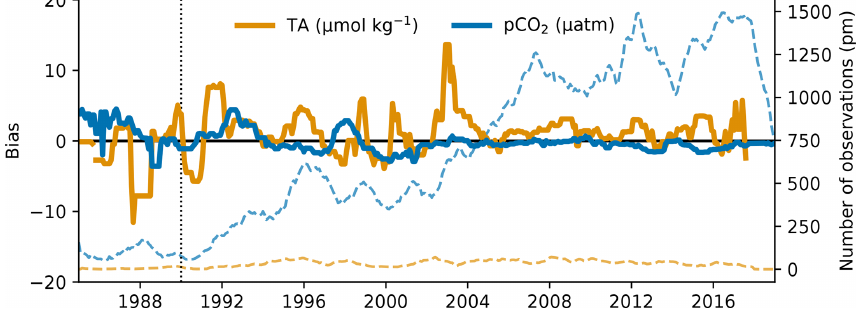
Figure A1. Time series of TA (orange) and p CO 2 (blue) estimates, with the respective training data sets (GLODAPv2 and SOCAT). The dashed lines show the number of training data (right axis). The vertical line shows the year 1990, before which OceanSODA-ETHZ p CO 2 estimates tend to be larger than other gap-filling estimates of p CO 2 .